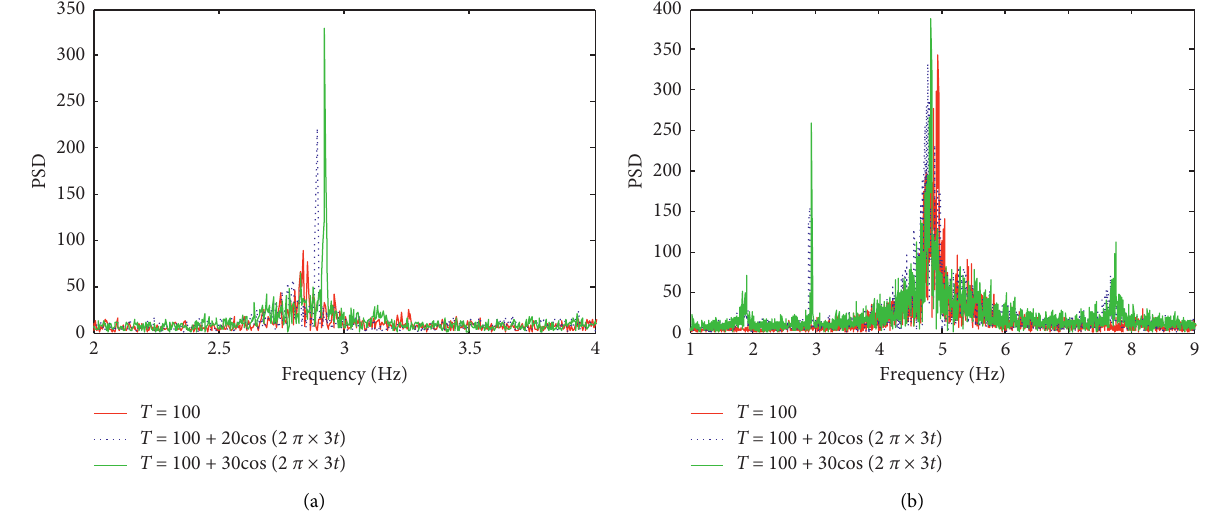
Figure 12: Frequency spectrum of TTR: (a) U � 0.3m/s; (b) U � 0.5m/s.